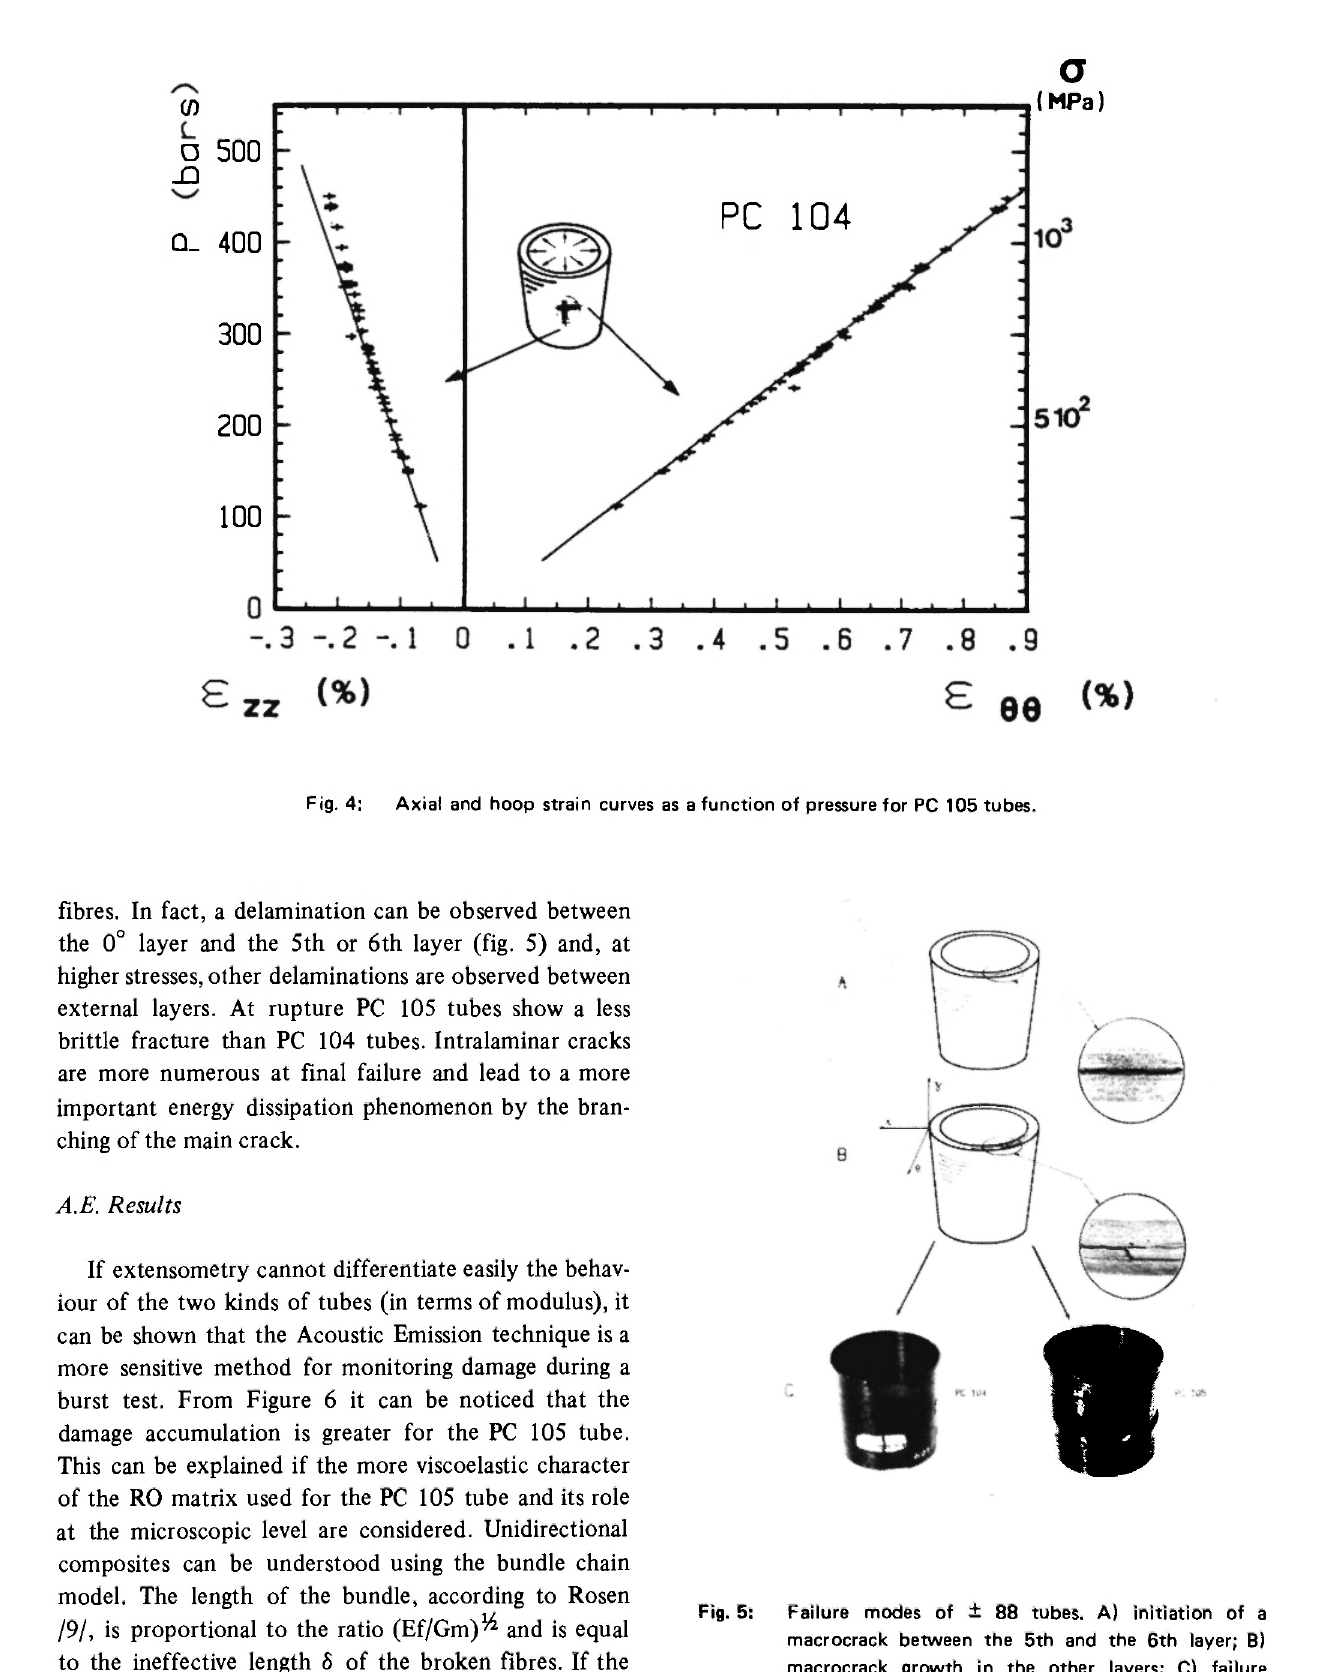
Fig. 5: Failure modes of ± 88 tubes. A) initiation of a macrocrack between the 5th and the 6th layer; B) macrocrack growth in the other layers; C) failure aspect as a function of the matrix